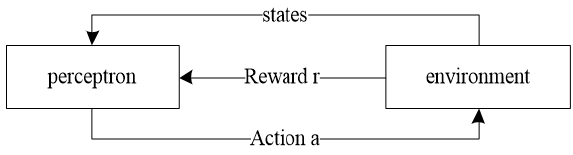
Fig. 1. Reinforcement learning model.